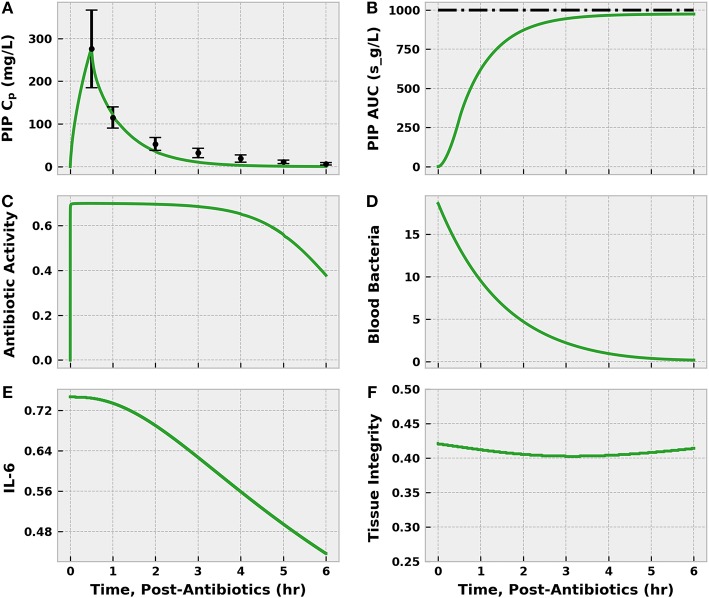
The effect of infusing 4.5 g piperacillin/tazobactam (PIP) over 30 min to the septic patient. The infusion began at 46 h post-infection (i.e., after initial fluid challenge), which we define as 0 h post-antibiotics. The plasma concentration (CP) estimated by the BioGears Pharmacokinetic model (green line) agrees closely with the values reported in Sörgel and Kinzig (1993) (black points) (A). Error bars were estimated from individual subject data points plotted by Sörgel and Kinzig (1993). Further validation of the timing of piperacillin absorption and elimination predicted by BioGears can be seen in the calculated (green) and observed (black) area under the curve (AUC) (B). Sörgel and Kinzig (1993) reported a value of 278 mg-h/L, which is ~1,000 s-g/L. The antibiotic activity parameter (C), which reduces the bacteria growth rate, is a function of the unbound piperacillin plasma concentration and the MIC of the bacteria (16.0 mg/L in this simulation). Piperacillin exerts its maximal antibiotic effect (estimated at 0.70/h in our model) for ~3 h as the plasma concentration remains well above the MIC. As a result, the blood bacteria population (D) declines over the 6 h of observation. Reduction in bacteria count helps resolve excessive pro-inflammation and suppress IL-6 activation (E). The decrease in pro-inflammation leads to improvements in tissue integrity (F).